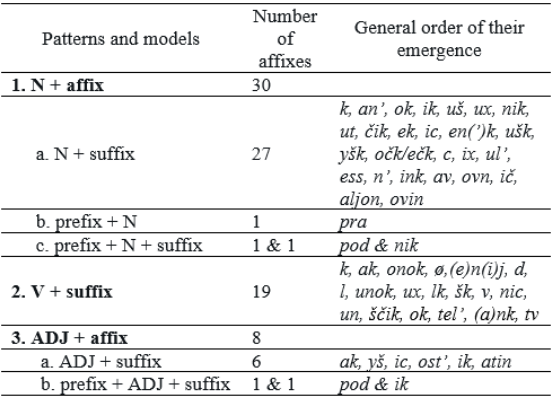
Table 4. Affixes in early nominal deriv -